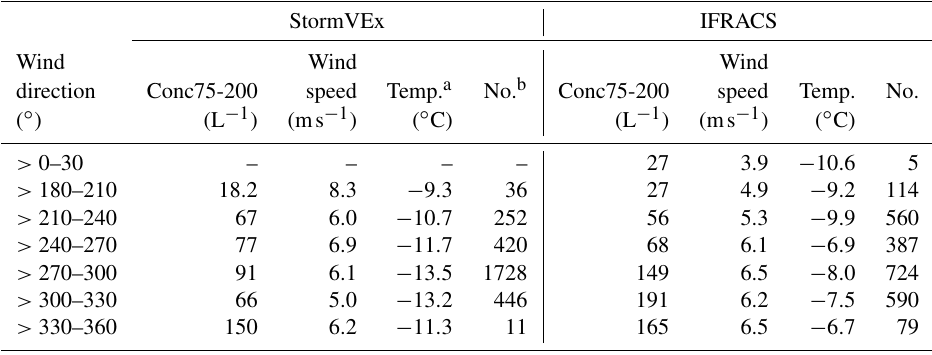
Table 2. Frequency distribution of Conc75-200, wind speed, and temperature as a function of wind direction. StormVEx IFRACS Wind Wind Wind direction Conc75-200 speed Temp. a No. b Conc75-200 speed Temp.